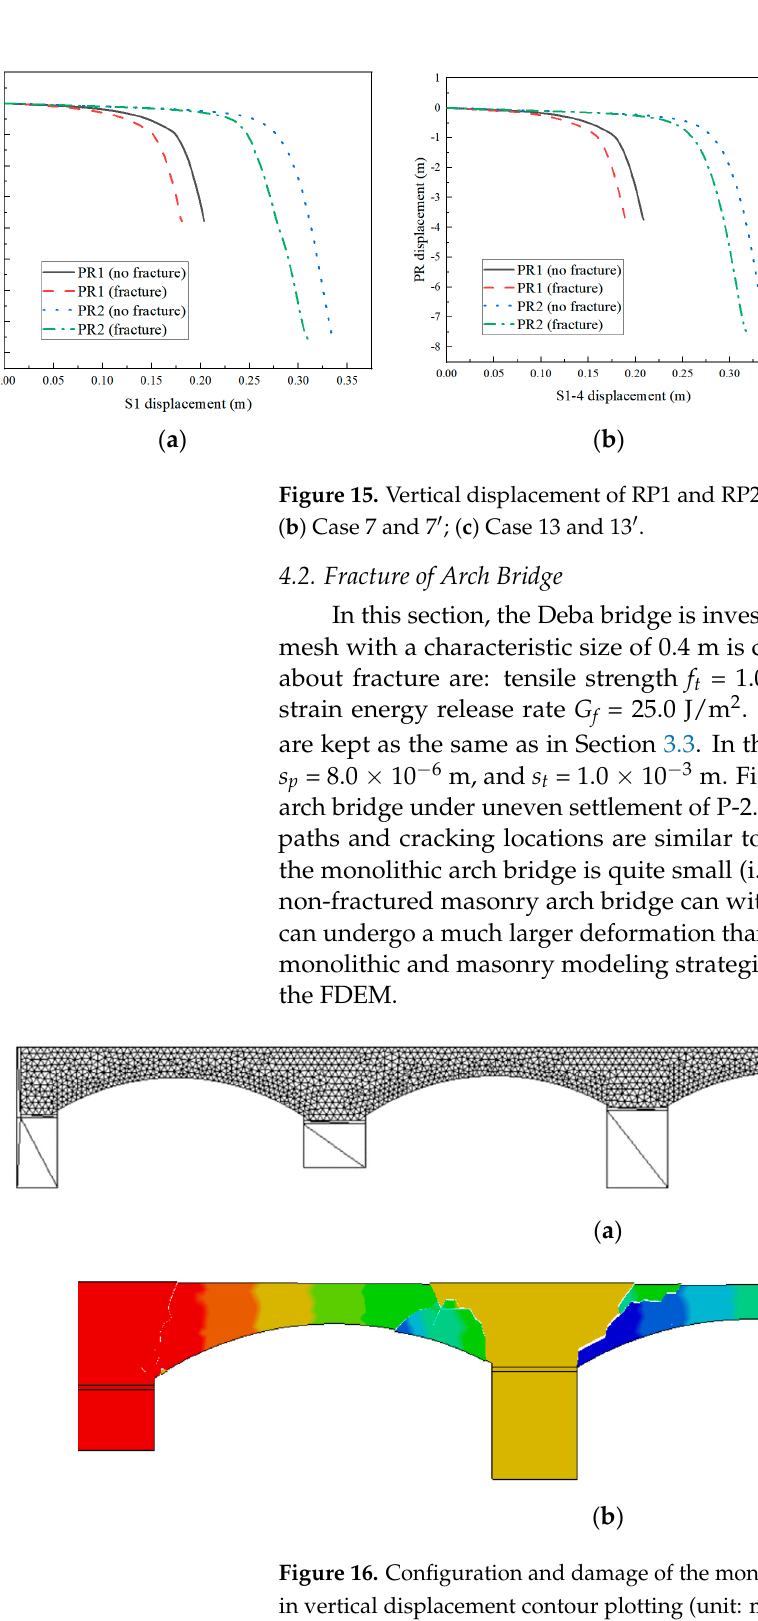
Figure 14. Ultimate support displacement of the colonnade considering fracture.